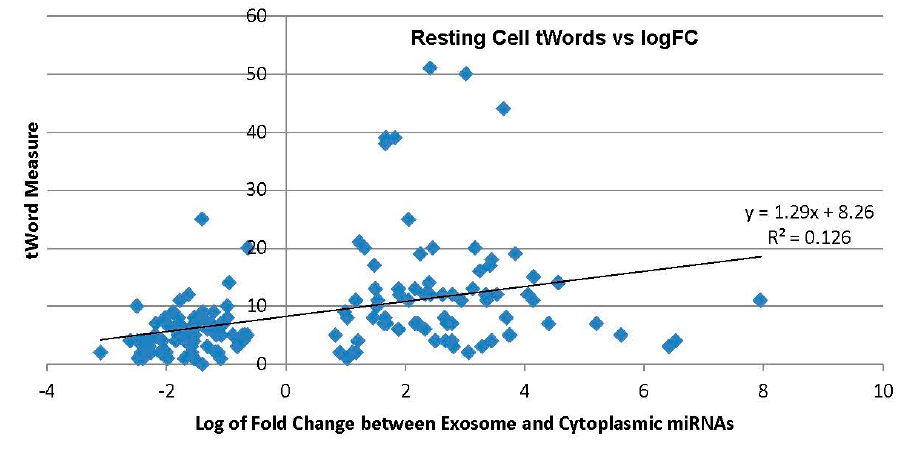
Figure 3. Resting cell miRNA tWords vs. Log fold change between exosome and cellular compartments. Trendline added.